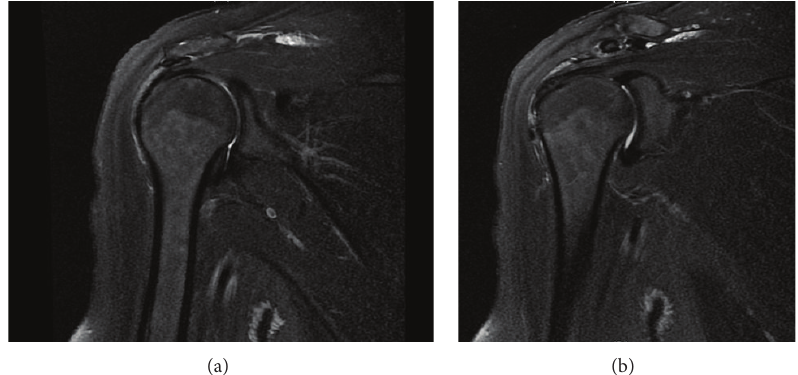
Figure 2: Preoperative T2-weighted, coronal oblique MRI showing (a) a small, nearly full-thickness tear of anterior supraspinatus tendon as well as (b) multiple extratendinous ossific densities consistent with synovial